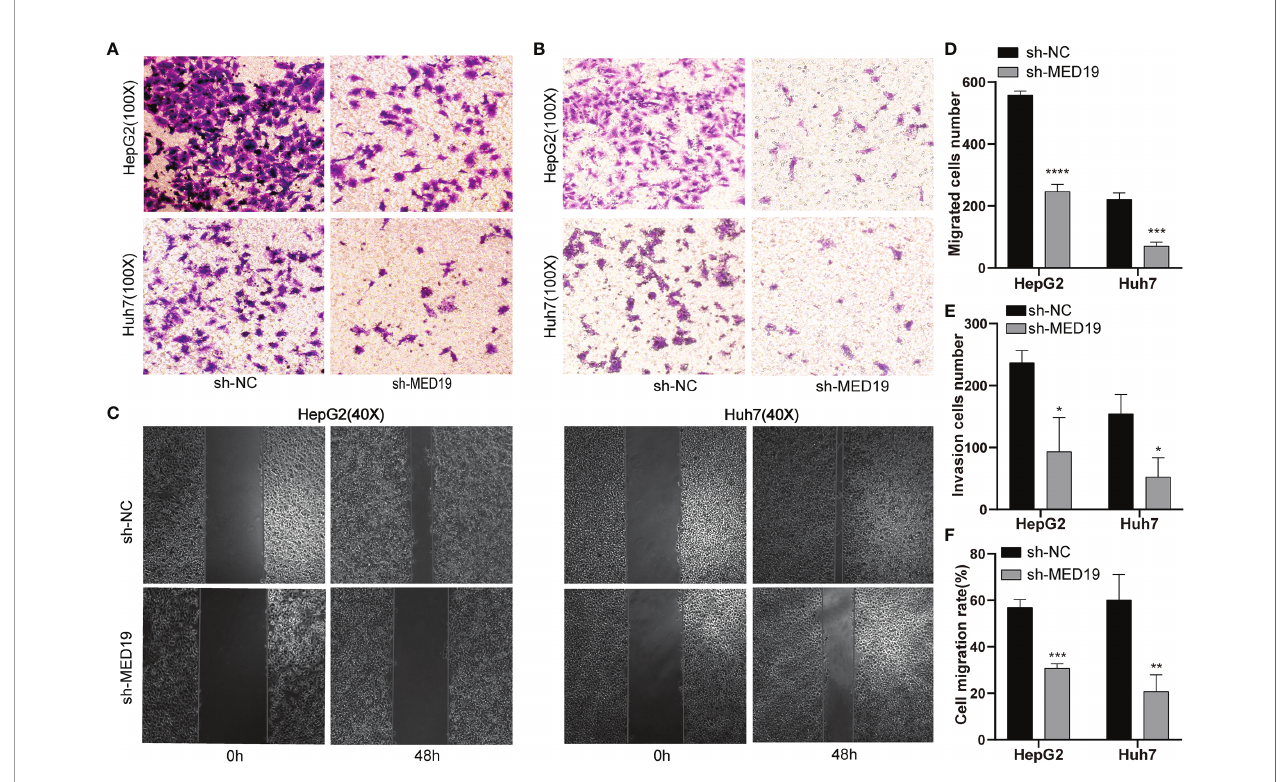
FIGURE 4 | MED19 knockdown inhibited the migration and invasion of HCC cells in vitro . (A, D) Transwell assay was used to detect the migration of HCC cells between the sh-NC and the sh- MED19 group. (B, E) Transwell assay was used to detect the invasion of HCC cells between the sh-NC and sh- MED19 groups. (C, F) Wound-healing was utilized to evaluate the effect of MED19 knockdown on the migration of HCC cells. * P < 0.05; ** P < 0.01; *** P < 0.001, **** P < 0.0001. Perform three independent replicates. Statistical analysis is performed using an unpaired t - test. All results are expressed as mean ±